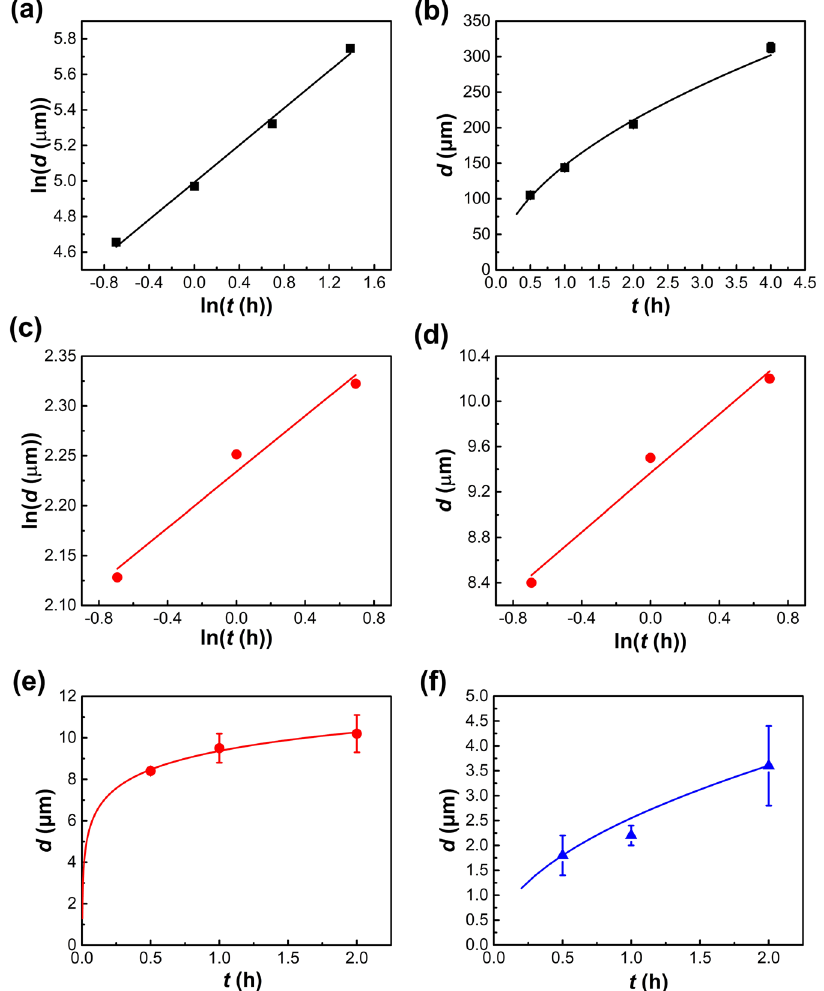
Fig. 9 Oxidation kinetics analysis of Zr and Cr. a Logarithm of the thickness of a ZrO 2 and c Cr 2 O 3 versus the logarithm of oxidation time; thickness of d Cr 2 O 3 versus the logarithm of oxidation time; the relationship between the thickness of b ZrO 2 , e Cr 2 O 3 , f Cr-Zr layers and the oxidation